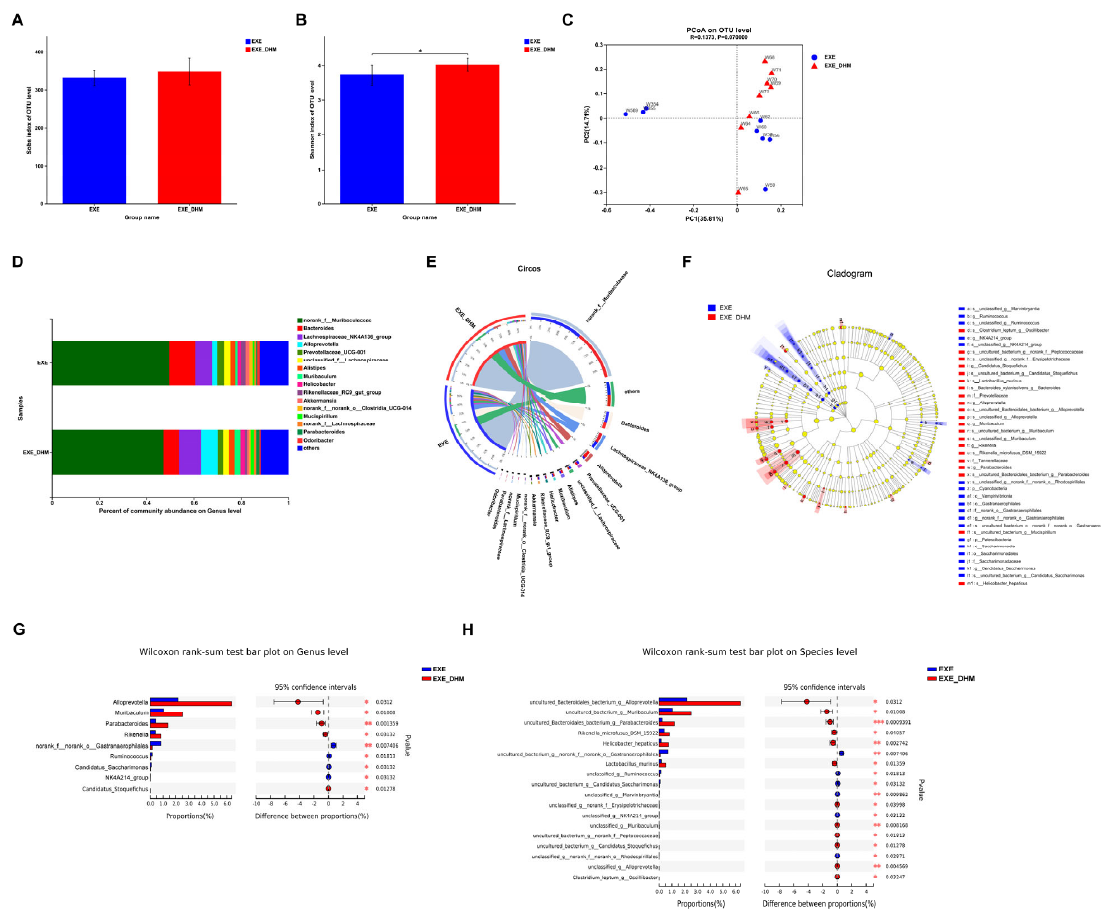
Figure 6. Dihydromyricetin alters the gut microbiota profile in exercised mice. ( A , B ) The OTU ‐ level alpha diversity indices such as Sobs ( A ) and Shannon ( B ) index. ( C ) Weighted UniFrac PCoA anal ‐ ysis on OUT level. ( D ) Community composition analysis on genus level. ( E ) The relationships be ‐ tween samples and bacteria at the genus level were analyzed by Circos. ( F ) Linear discriminant analysis effect size (LEfSe) analysis from phylum to genus level. ( G , H ) Relative abundance and Wil ‐ coxon rank ‐ sum test bar plot on Genus ( G ) and Species ( H ) level. Data are expressed as the mean ± SEM. Unpaired t ‐ test: ( A , B ). * p < 0.05.